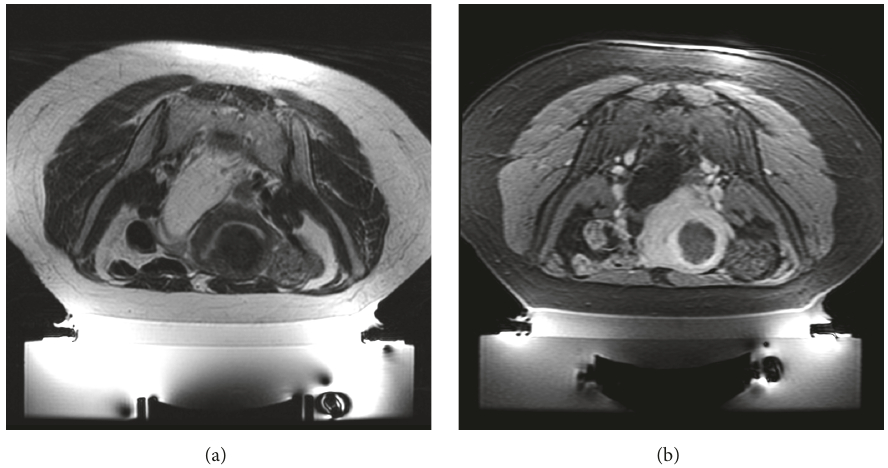
Figure 7: Case 5 : example of a treatment with a very high ablation rate (NPV = 99%); (a) screening axial T2-w scan; (b) sagittal T1-w with fat saturation acquired after intravenous injection of paramagnetic contrast medium acquired at the end of the